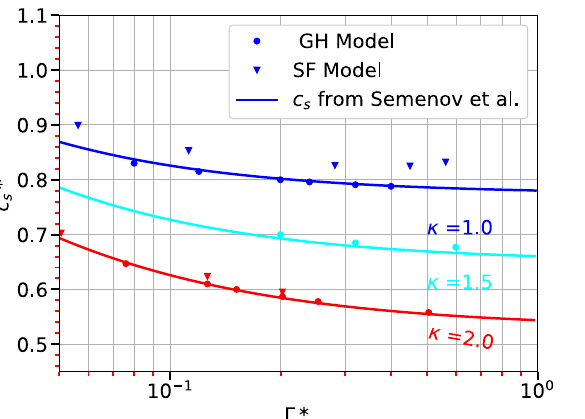
(a) Sound speed as afunction o f coulomb coupling parameter (b) Adiabatic constant ( ) as afunction o f coulomb coupling (triangles). parameter (Crosses). Figure 6. Comparison of sound speed and adiabatic constant across with results from Semenov et al. 50 (solid lines). Following the same normalization used in Ref. 50 , the sound speed is c s κ/(ω pd a ws ) and effective coulomb coupling parameter as Ŵ normalized as c s ∗ =